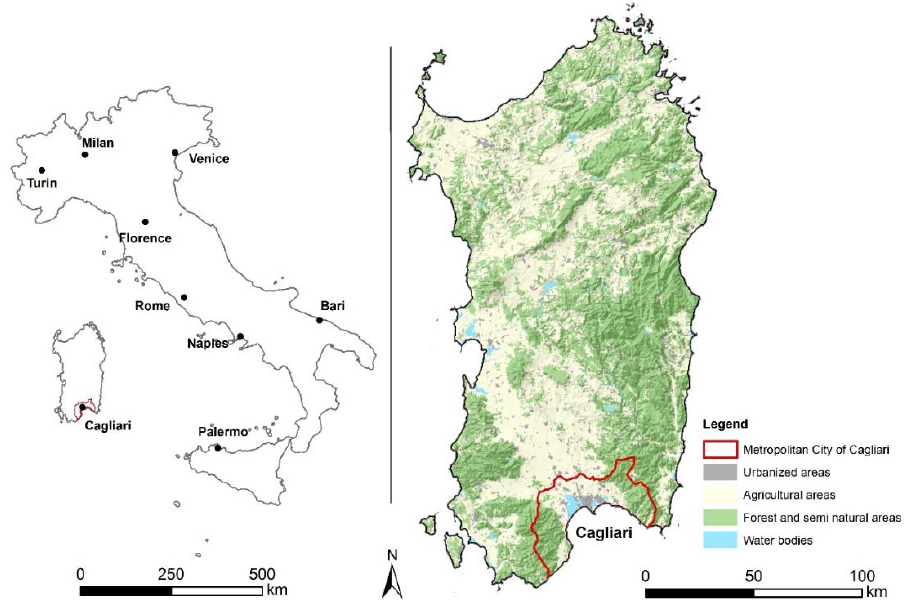
Figure 1. Location of the case study in the Italian and Sardinian context: the red line bounds the Metropolitan City of Cagliari.